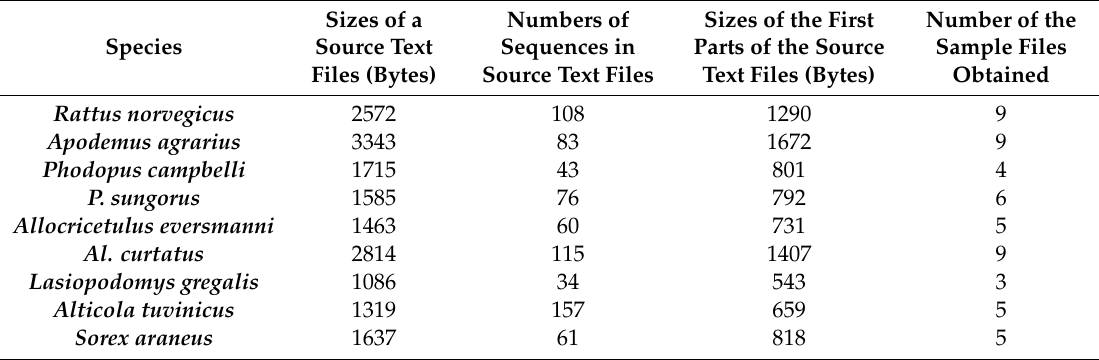
Table 4. The volumes of data